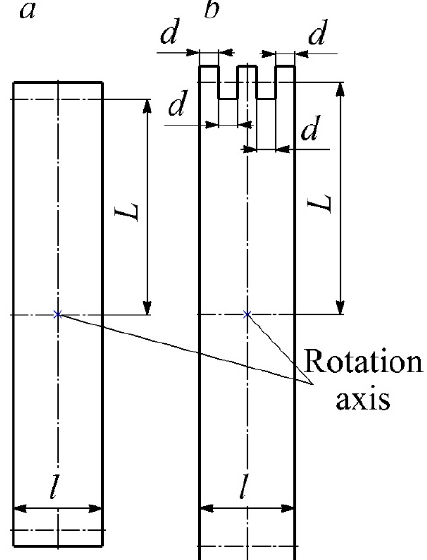
Figure 6. Blade configurations for dynamic calibration of the measuring system: ( a )—one–piece blade; ( b )—blade with slots: l —blade width; L —distance from the blade axis to the center of the hole; d —linear size of the slots.